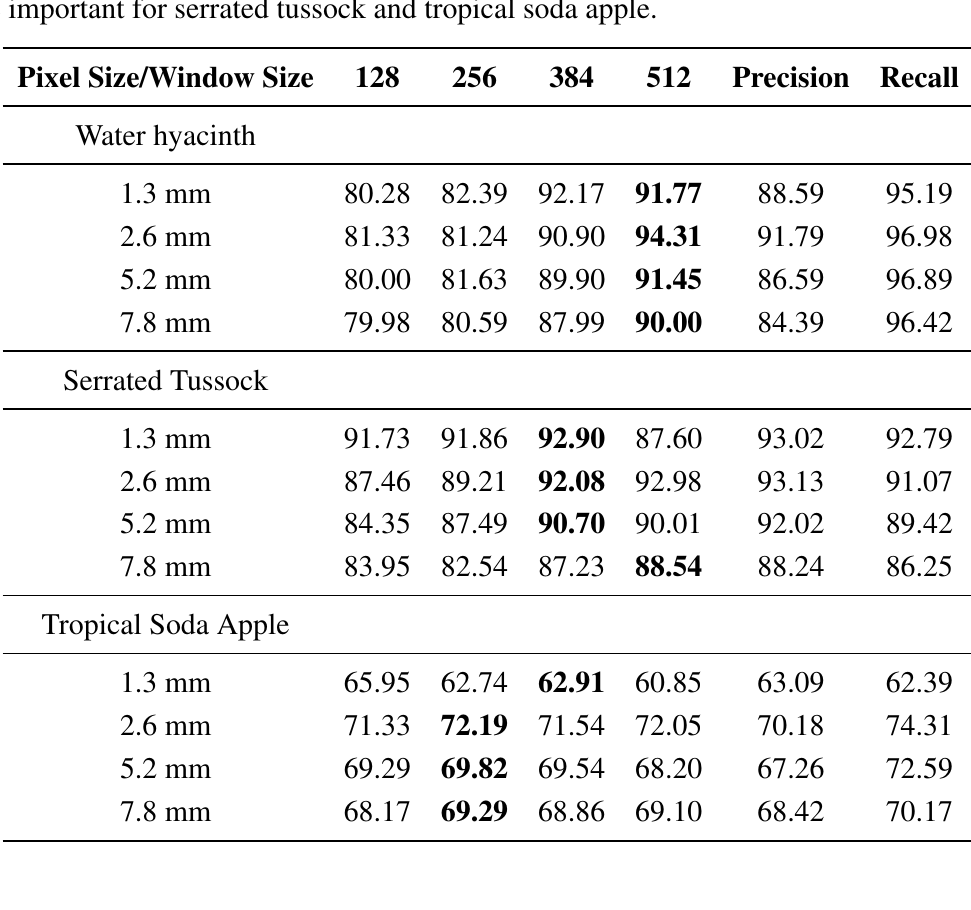
Figure 9. Serrated tussock patches sampled with different window sizes. The classification accuracy improved with increasing the window size up to 384 pixels. This is the dimension at which most of the serrated tussock plants can be fully